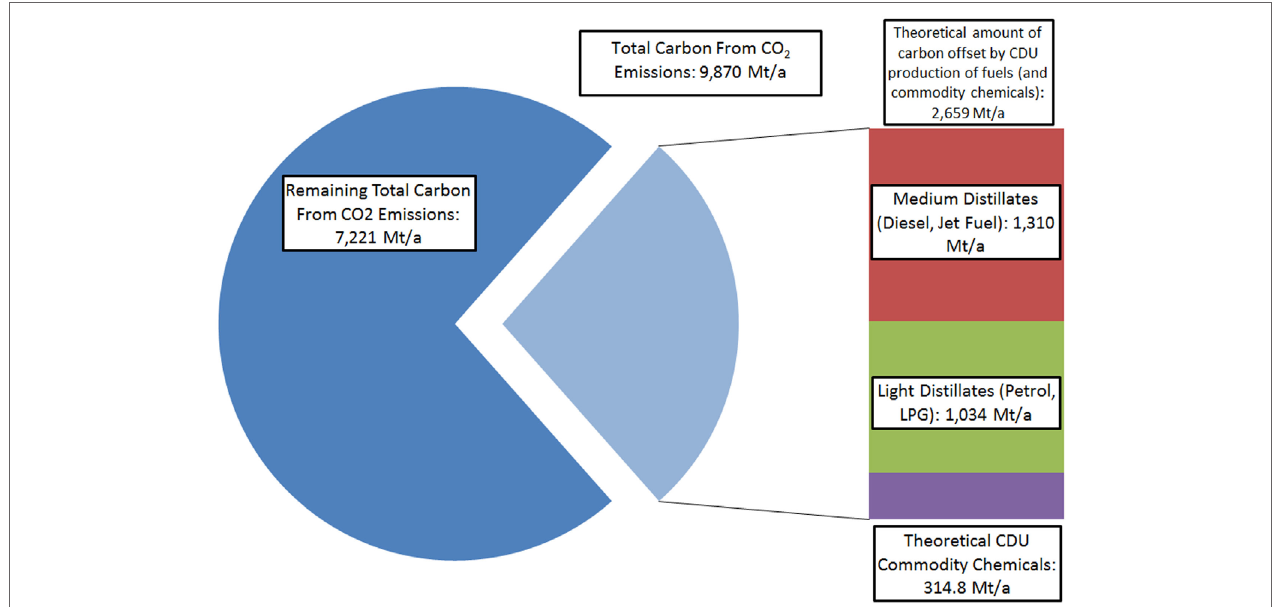
FigUre 2 | Comparison of total carbon in global CO 2 emissions compared to carbon atoms contained in major liquid fuels and the theoretical collective commodity chemicals shown in Figure 1 . 2015 Figures used (Dudley,